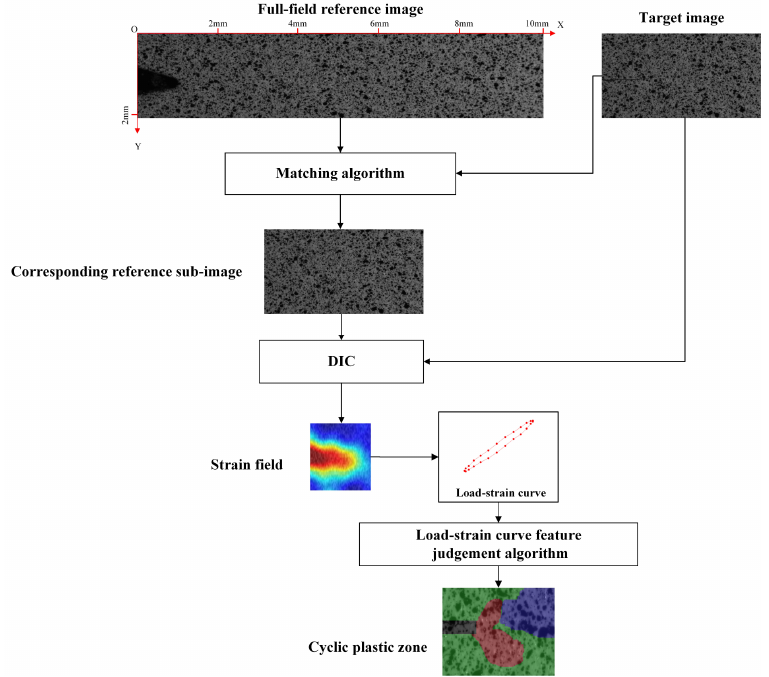
Figure 8. The measurement process of CPZ near the crack tip region.